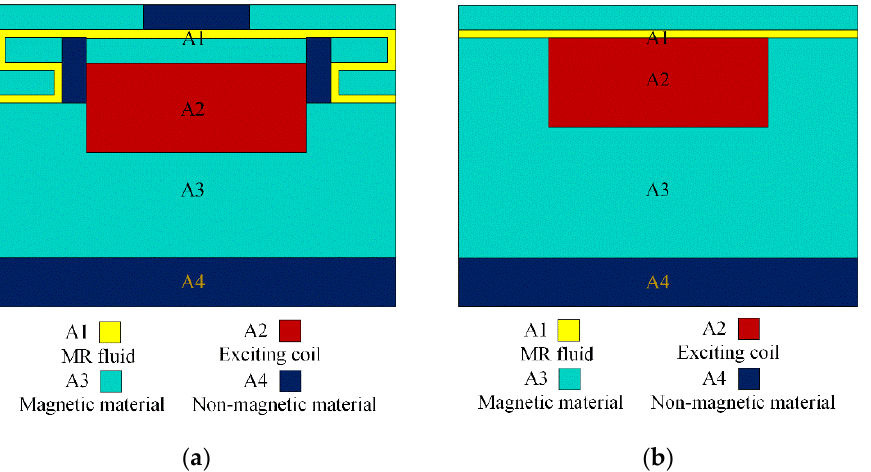
Figure 5. Axisymmetric model for the FEA: ( a ) Proposed MR damper; ( b ) Traditional MR damper.